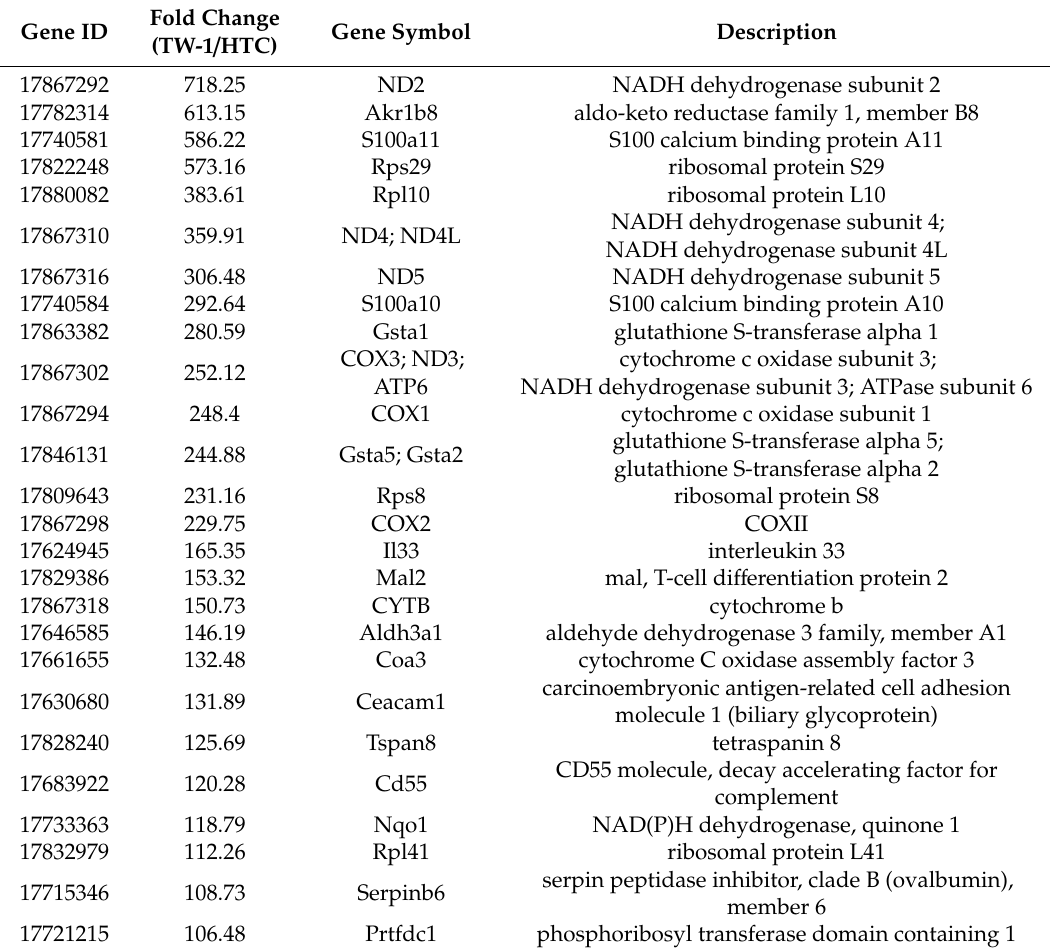
Table 1. The microarray analysis results for HTC and